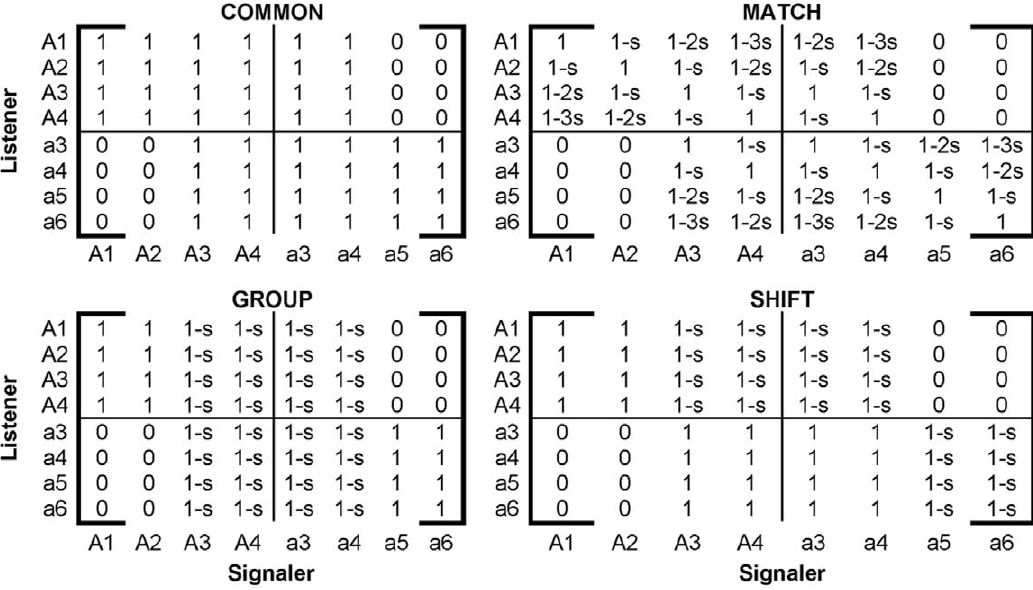
Figure 1. Affinity schemes. The matrices represent the relative weight that a listener of phenogenotype i gives to a singer of phenogenotype j for each of the four affinity schemes. The phenogenotypes of listeners and receivers are labeled on the schemes. Break lines have been included to group cases by genotype. The variable s describes a reduction in the affinity. Default values of s are: Match, s =.1; Group or Shift, s =.25. The Common scheme is equivalent to any of the above schemes with s =0.